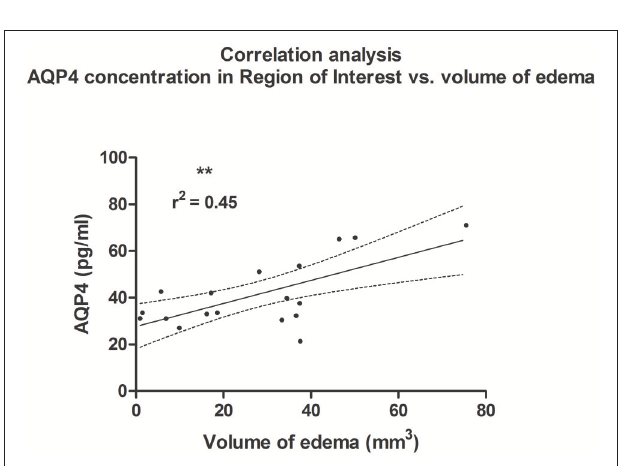
FIGURE 6 | Histogram presenting analysis of correlation between volume of edema 24h after trauma/sham injury and AQP concentration, assessed in contralateral hemisphere at the level of injury (ROI contralateral). There was a correlation between increased volume of brain edema and elevated concentration of AQP4 according to ELISA ( r 2 = 0.45; p = 0.003; **).